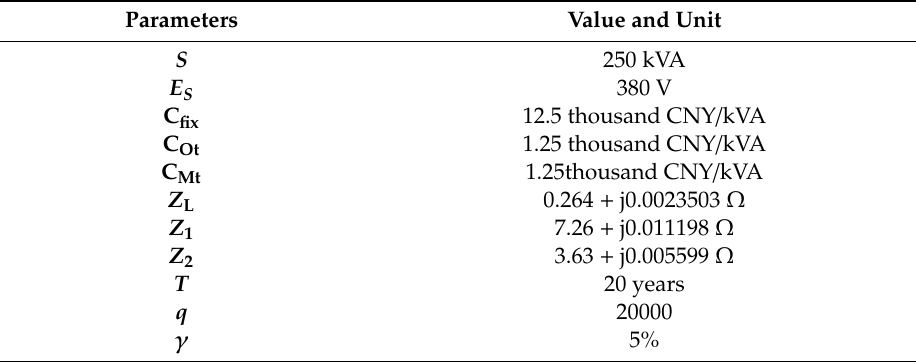
Table 3. Simulation parameters of system with DVR